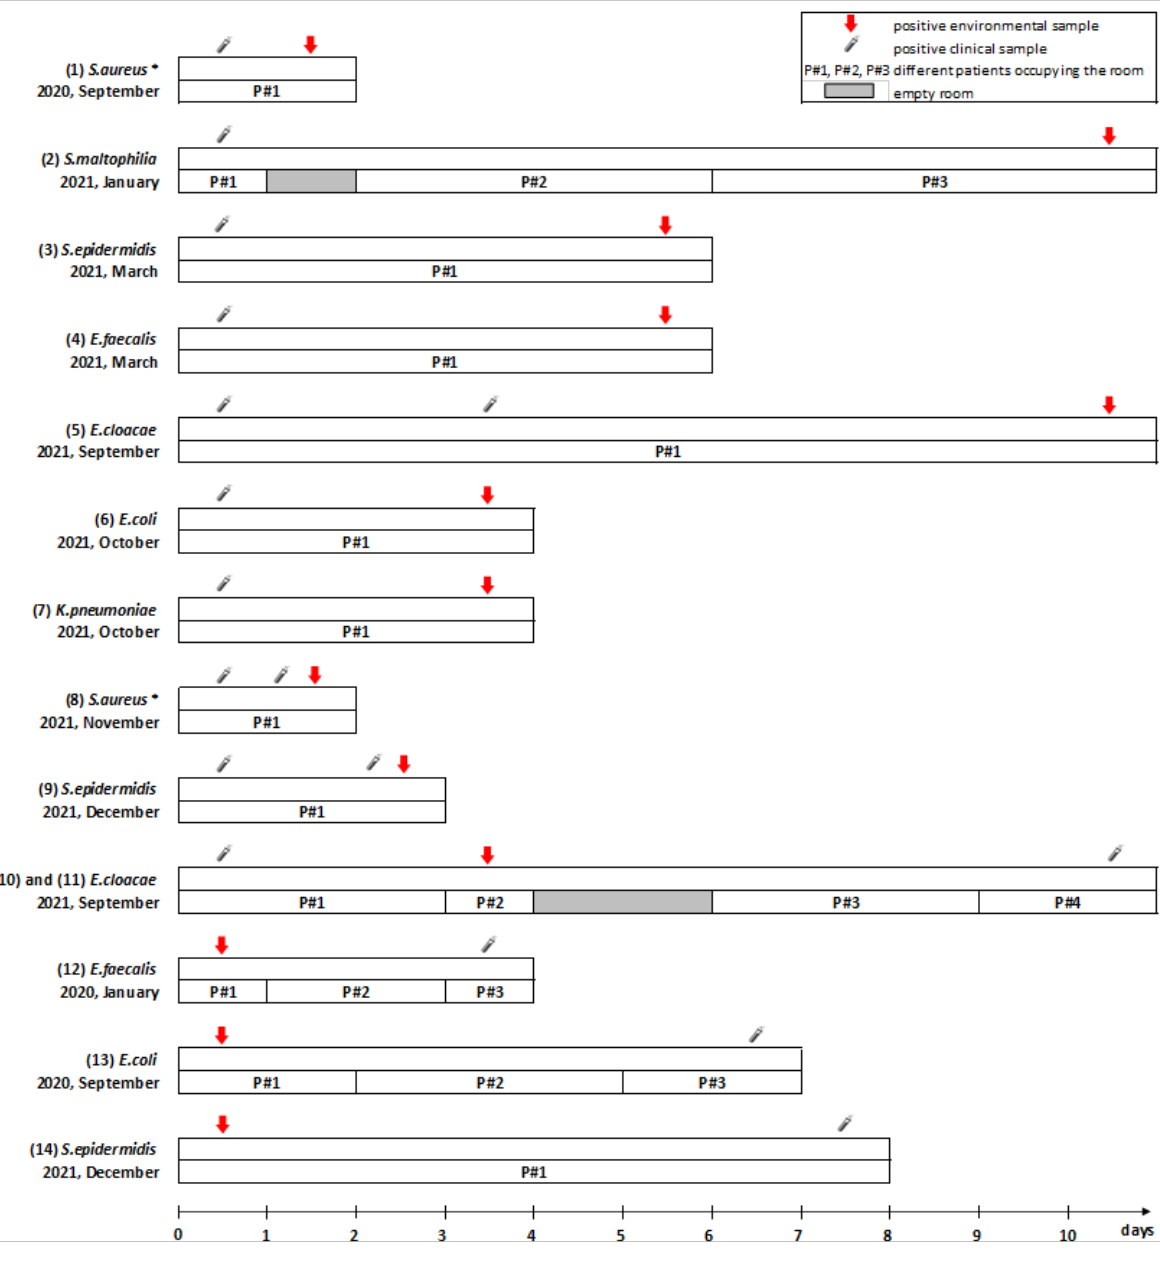
Table 2, from 1 to 10); (ii) four cases of potential transmission environment–patient, in which the same bacterium was found first in the environment and then in patient clinical samples (average delay 5.8 ± 1.9 days, median 6.5 days) (Figure 3 and Table 2, from 11 to 14). We did not find a significant difference between the delay of the contaminations from the environment to the patient versus the contaminations from the patient to the environment ( p = 0.19). Similarly, the delay from the last cleaning of the room did not show any difference, regarding potential cross-contamination or not (21.0 ± 2.8 h, median: 22.0 h, n = 12, vs. 23.1 ± 7.6 h, median: 22.0 h, n = 16, p = 0.37).